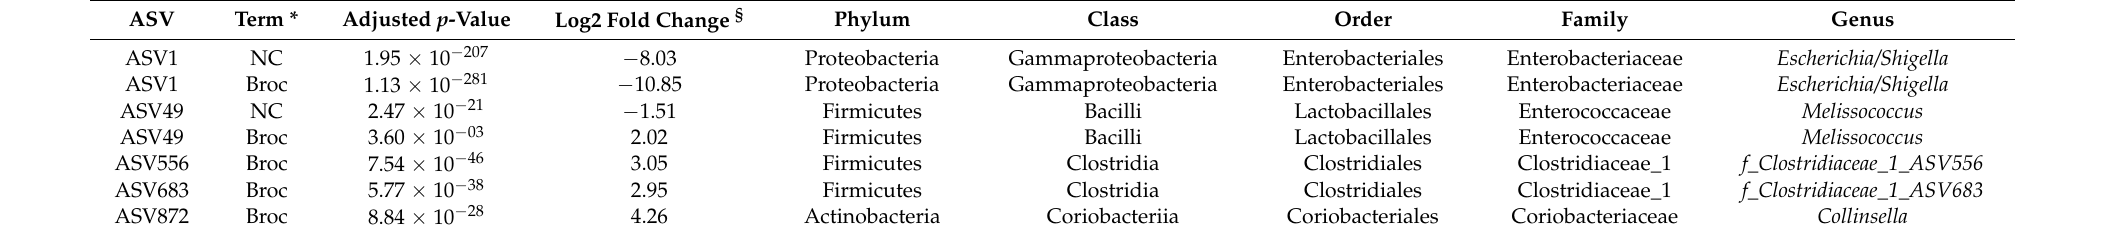
Table 1. ASVs differentially abundant between high and low nitrile